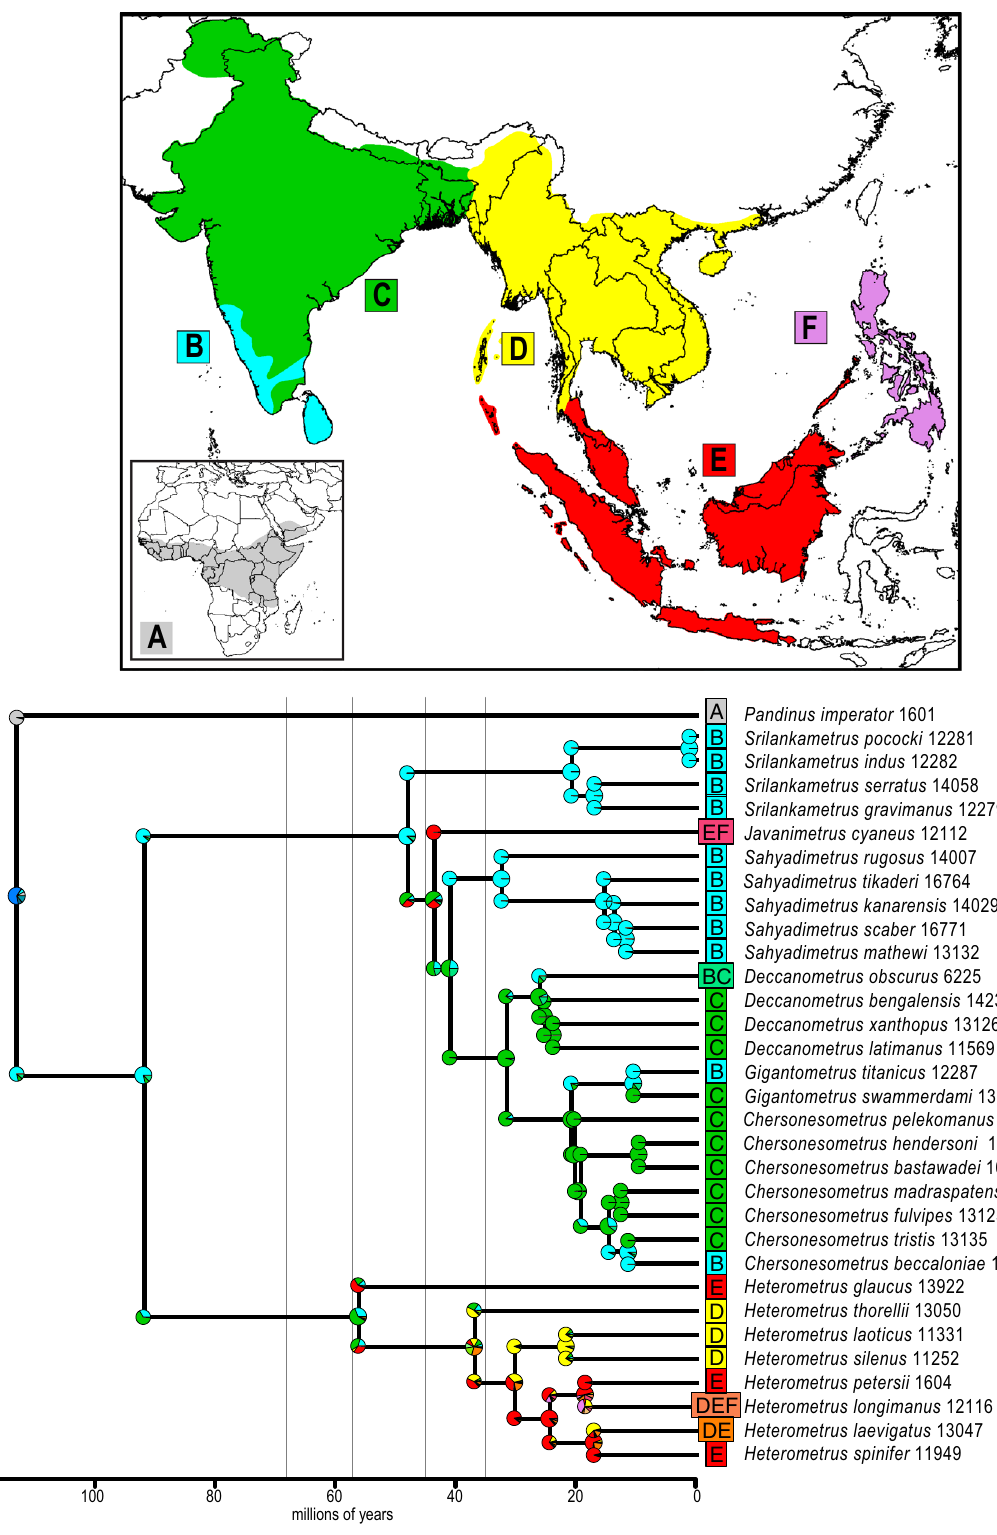
Figure 3. Estimation of ancestral ranges of the Asian forest scorpions (Scorpionidae: Heterometrinae) in six biogeographical regions: Africa ( A ); Western Ghats and Sri Lanka ( B ); Greater Indian Subcontinent ( C ); Indochina ( D ); Sundaland ( E ); Philippines ( F ). Lines on phylogeny indicate periods in the time-stratified analysis: 0–35 Ma, 35–45 Ma, 45–57 Ma, 57–68 Ma, 68–120 Ma. Map produced using ArcGIS v. 10.1 with ESRI (http://www.esri.com) World Countries layer, DeLorme Publishing Company, Inc.